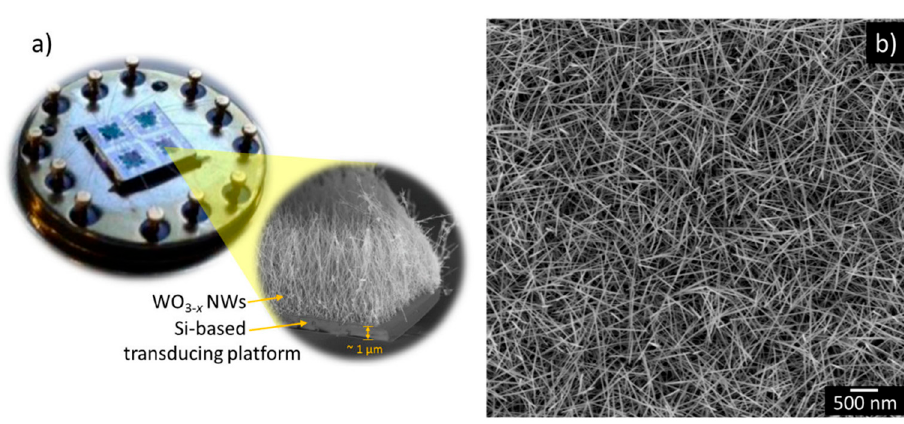
Figure 1. Photograph of the sensor device mounted on a TO-8 package and its cross-section after integration of the WO 3 − x NWs ( a ). SEM imaging (top-view) of the WO 3-x NWs ( b